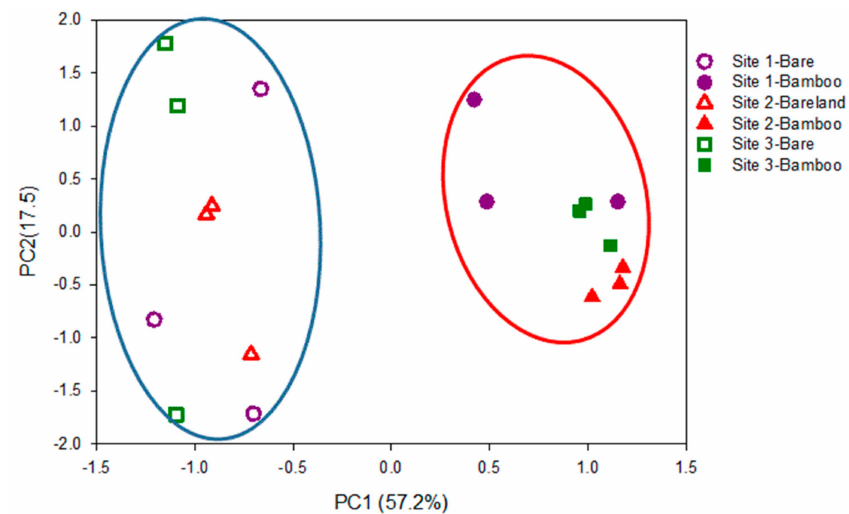
Figure 2. Score plots of the two first components (principal component (PC) in a principal component analysis) of the mole% of microbial phospholipid fatty acids (PLFA) in the soils at di ff erent